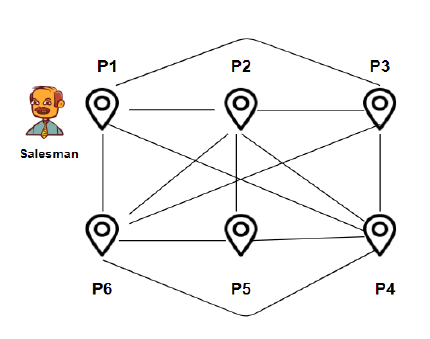
Fig. 6. Travelling Salesman